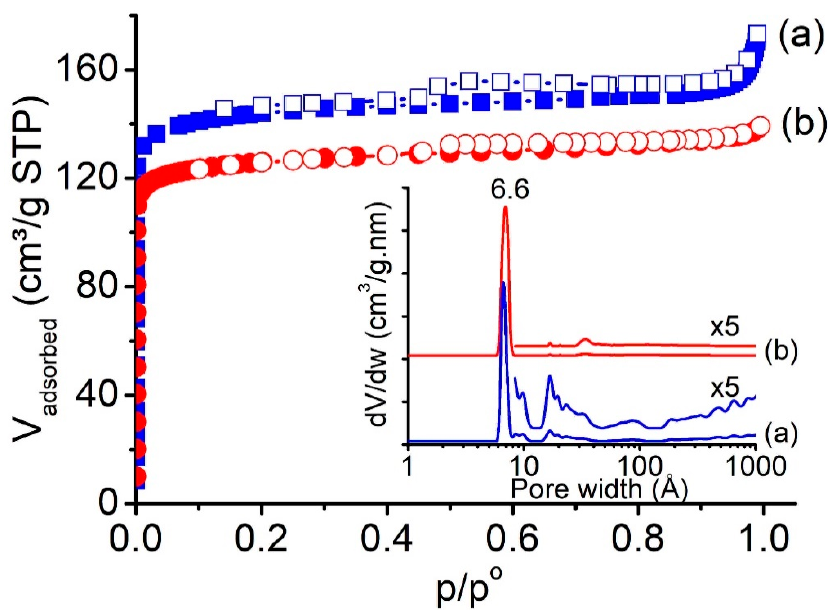
Figure 3. Nitrogen adsorption–desorption isotherms and (inset) pore size distributions of ( a ) CTA + -offretite and ( b ) TMA + -offretite zeolites. Table 1. Properties of offretite zeolites.